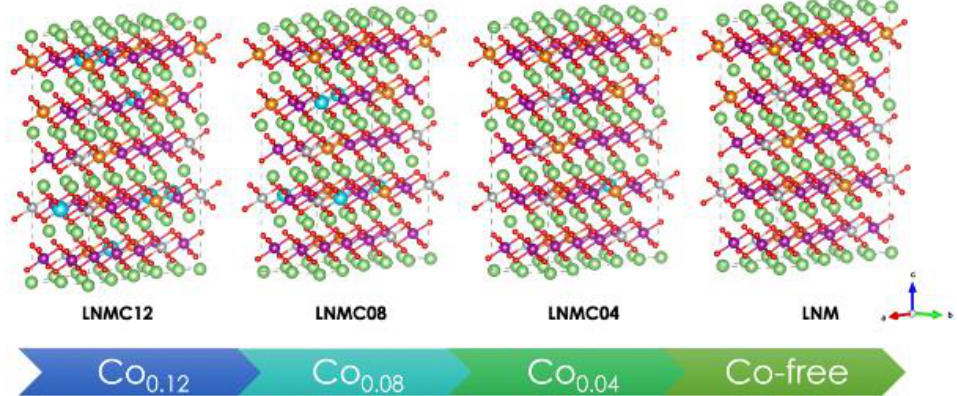
Figure 1. Optimized geometry and volume structures supercell 5 × 2 × 5/3 containing 200 atoms. On the left, Li 1.2 Ni 0.14 Mn 0.54 Co 0.12 O 2 (LNMC12). In the middle, Li 1.2 Ni 0.16 Mn 0.56 Co 0.08 O 2 (LNMC08), and Li 1.2 Ni 0.18 Mn 0.58 Co 0.04 O 2 (LNMC04). On the right Li 1.2 Ni 0.2 Mn 0.6 O 2 (LNM). Color code: Li light green; LiTM orange; Ni grey; Mn purple; Co light blue; and O red.